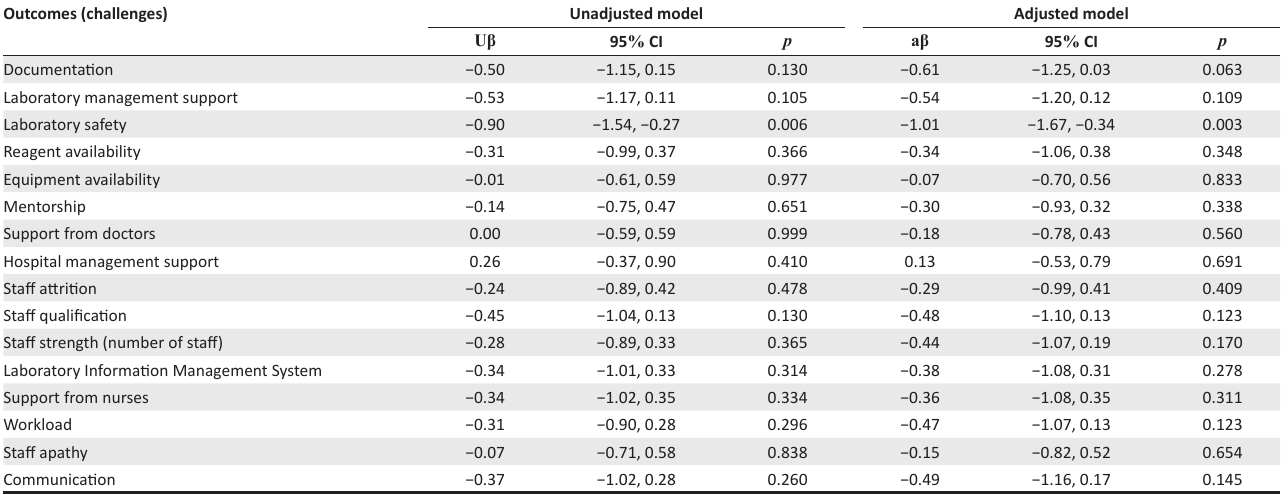
TABLE 2: Multivariate regression model comparing the scores of key challenges between personnel who joined the Pathology Division Laboratory, 37 Military Hospital, Accra, Ghana, before versus after accreditation, November 2020. Outcomes (challenges)